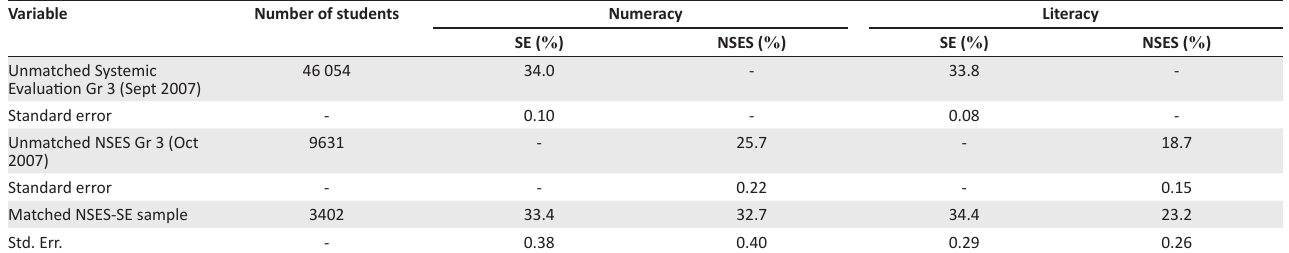
NSES, National School Effectiveness Study. TABLE 4: Average student performance in numeracy and literacy in the Systemic Evaluation and the NSES by matched and unmatched samples.